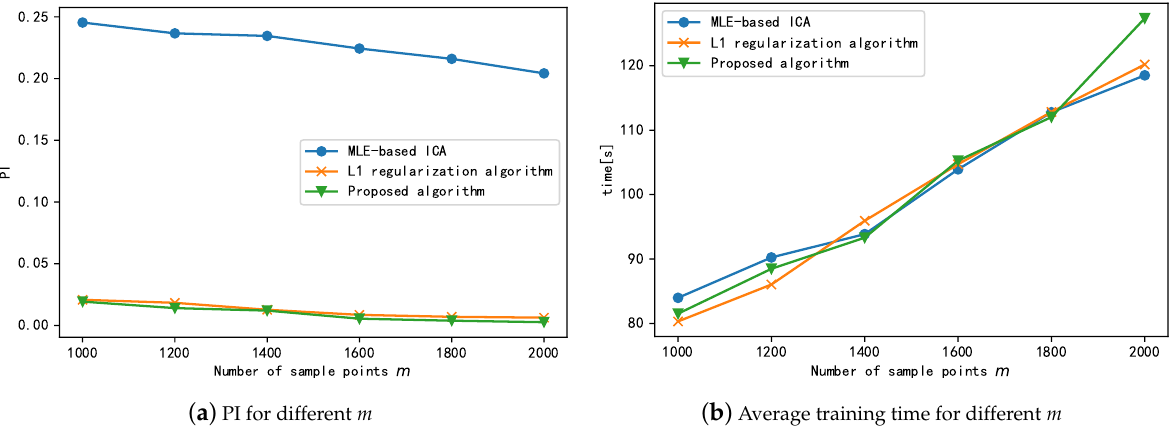
Figure 10. Effect of sampling points m on algorithm performance and training